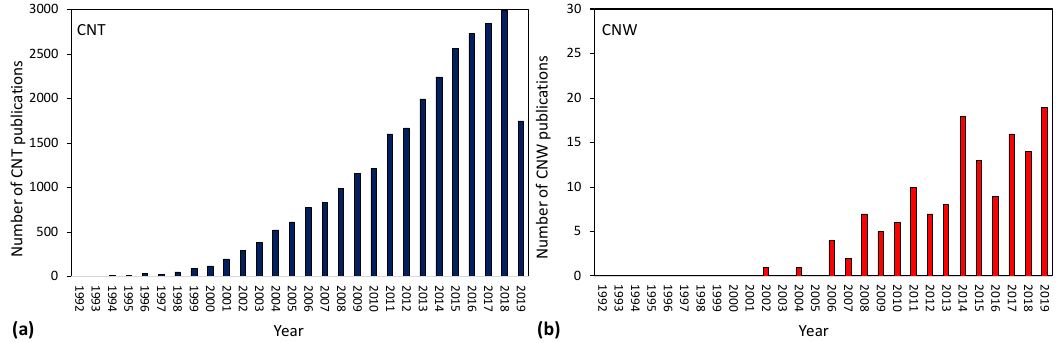
Figure 1. Number of publications per year regarding carbon nanotube (CNT) synthesis ( a ) and carbon nanowall (CNW) synthesis ( b ). Source: Web of Science.